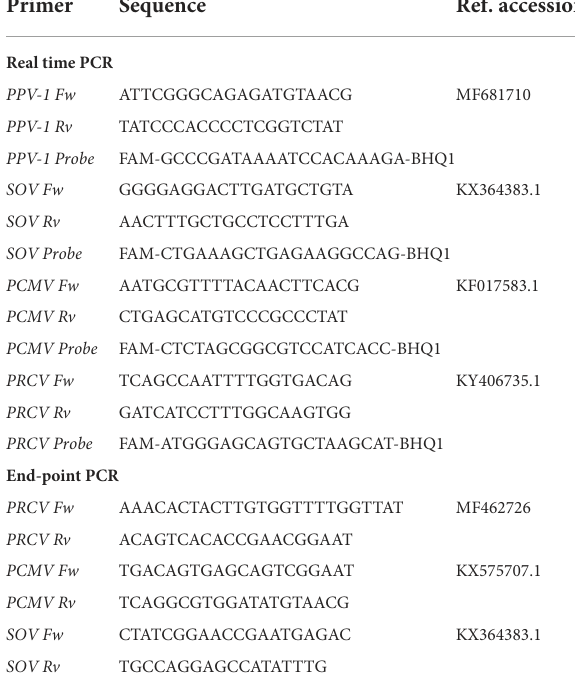
TABLE 1 List of primers and probes designed for the present study.